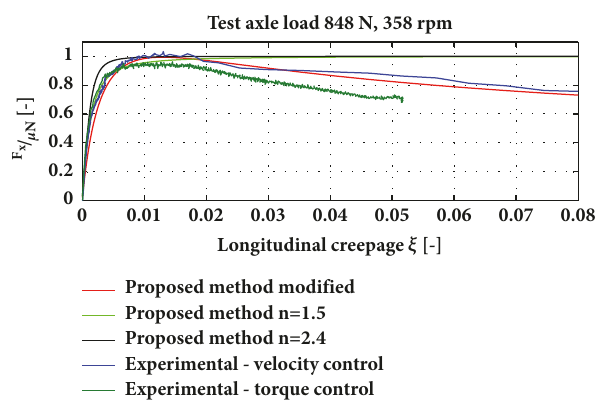
Figure 14: Normalized longitudinal tangential force on roller-rig, with an axle load of 848 N and a reference velocity of 358 rpm.